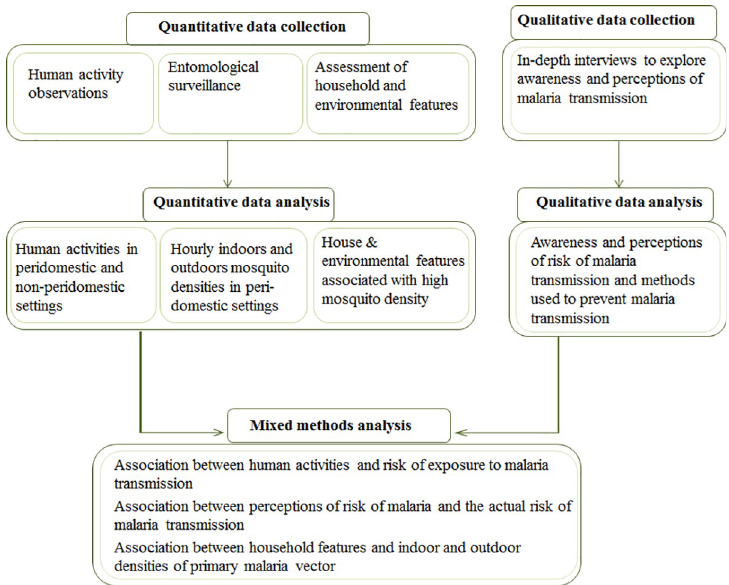
Fig 2. Illustration of the triangulation mixed methods design used to explore and assess factors associated with mosquito biting exposure in Ulanga and Kilombero districts, south-eastern Tanzania.